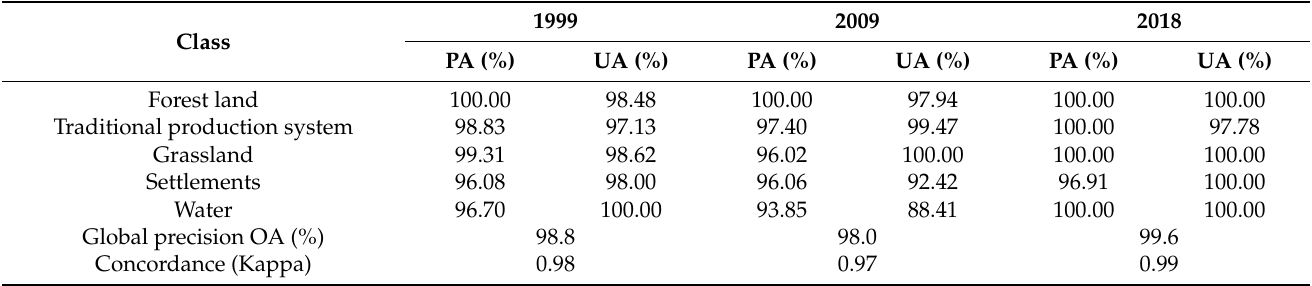
Table 3. Evaluation of the accuracy of the LULC classification in the Diversity and Life Zone in the Yasun í Biosphere Reserve of the Ecuadorian Amazon